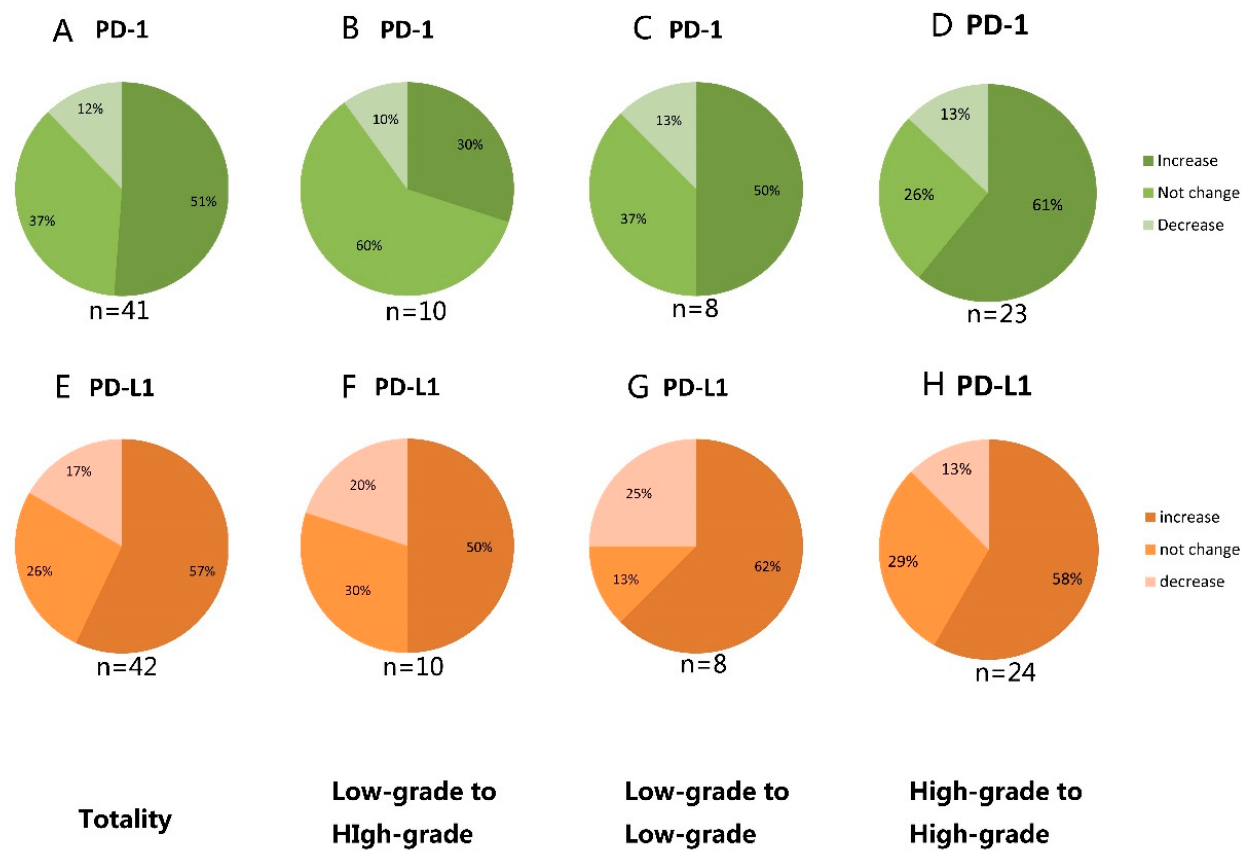
Figure 3. Change in PD-1 ( A – D ) and PD-L1 ( E – H ) expression from primary to recurrent glioma. ( A )